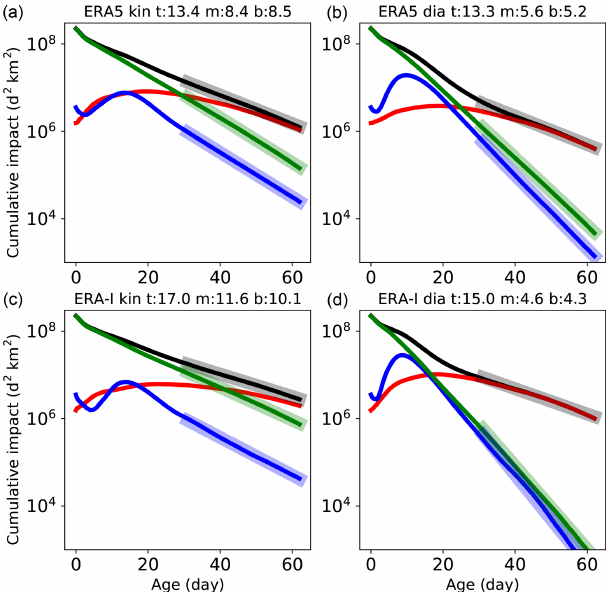
Figure 6. Evolution, as a function of age, of the total impact (black), the lower-layer impact for θ < 340K (blue), the mid-layer impact for 340K < θ < 370K (green) and the upper-layer impact for 370K < θ (red). The four panels are arranged as in Fig. 5. The asymptotic e -folding times of the total and upper layer for the four cases are 13.4, 13.3, 17.0 and 15d for, respectively, EAZ (ERA5- kin), EAD (ERA5-dia), EIZ (ERA-I kin) and EID (ERA-I dia). The asymptotic e -folding times (in days) for the top layer (t), mid-layer (m) and bottom layer (b) are listed in the title of each panel. They are calculated from the fit of an exponential law between ages 30 and 62d shown as wide segments in the